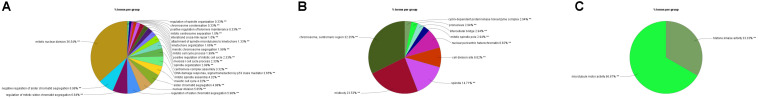
GO analyses of DEGs in the most significant module using Cytoscape plugins ClueGO and CluePedia. (A) Percentages of biological processes terms per group. (B) Percentages of cellular components terms per group. (C) Percentages of molecular functions terms per group.